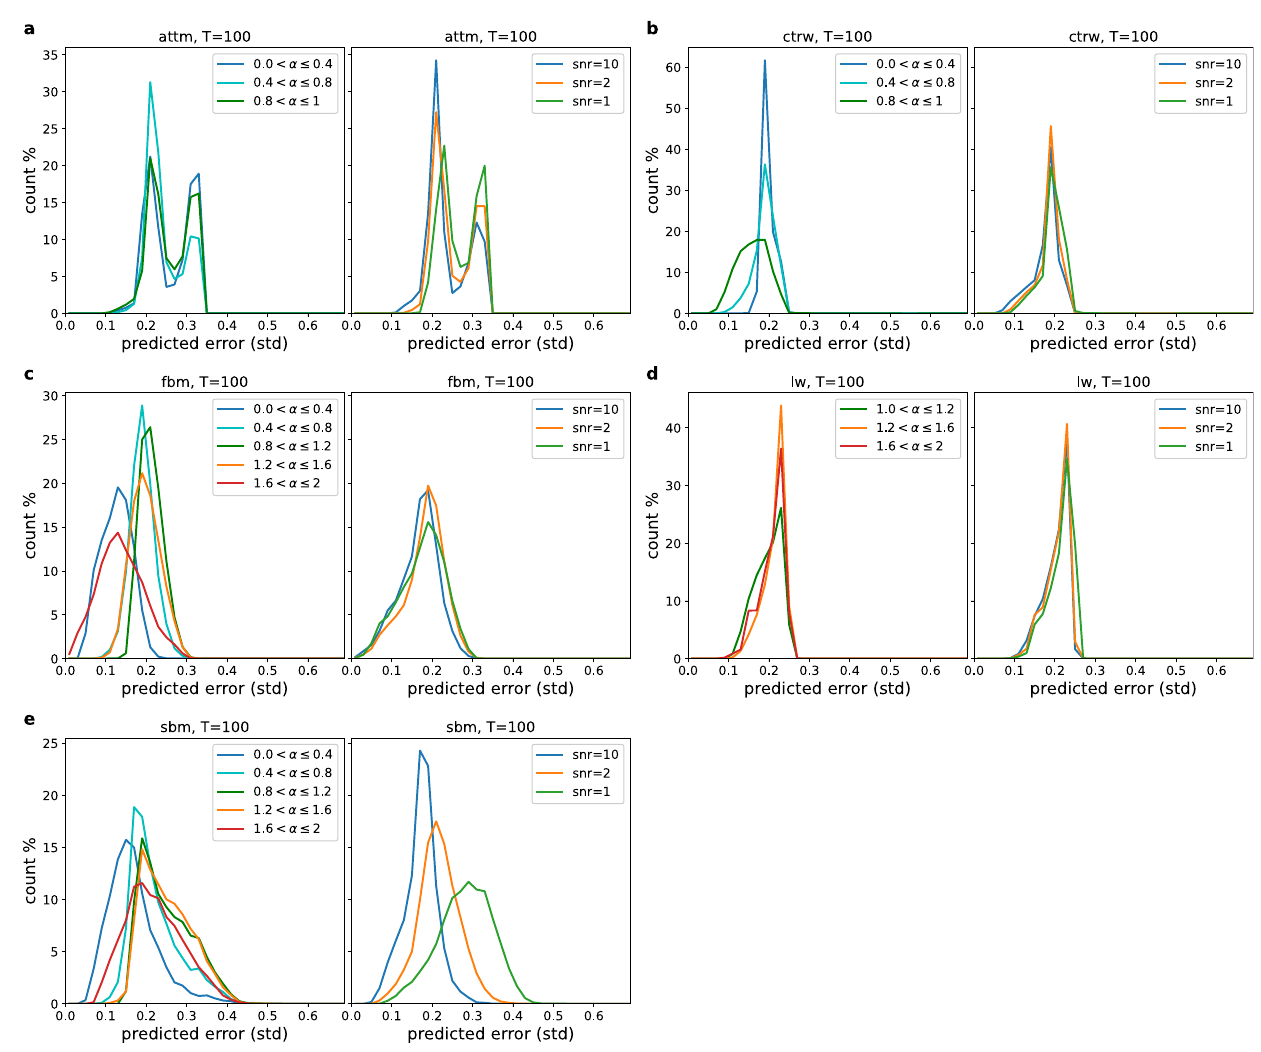
Fig. 6 | Predicted error histogram for known ground truth model, split by exponentandnoisefortrajectoriesoflength T =100. Eachofthe fi gures[ a FBM, b SBM, c ATTM, d CTRW, e LW] shows the results for one of the fi ve different